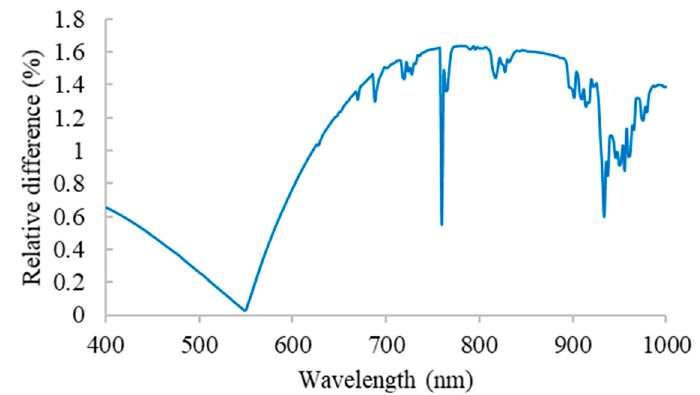
Figure 12. Relative difference between the calculated total downwelling irradiance for a real data set at Baotou assuming a desert model and a rural model.